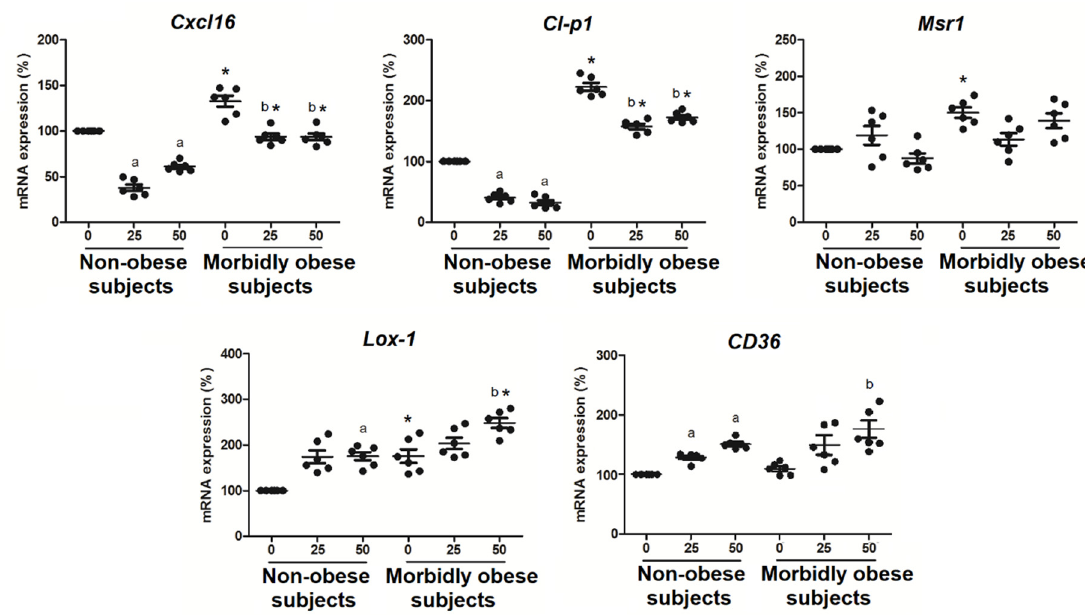
Figure 5. Levels of mRNA expression of scavenger receptors in the in vitro differentiated adipocytes obtained from HMSC from non-obese ( n = 6) and morbidly obese subjects ( n = 6) incubated with 0, 25 and 50 μ g/mL of oxLDL for 24h. a p < 0.05: significant differences with regard to 0 μ g/mL oxLDL within non-obese subjects. b p < 0.05: significant differences with regard to 0 μ g/mL oxLDL within morbidly obese subjects. * p < 0.05: significant differences for each dose between non-obese and morbidly obese subjects.